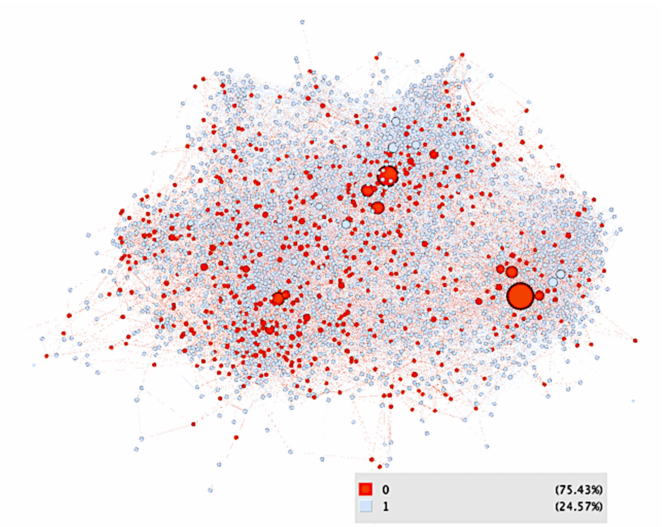
Figure 4. Visualization of the ACL ARC citations network to visualize the ACL papers and papers outside the ACL.